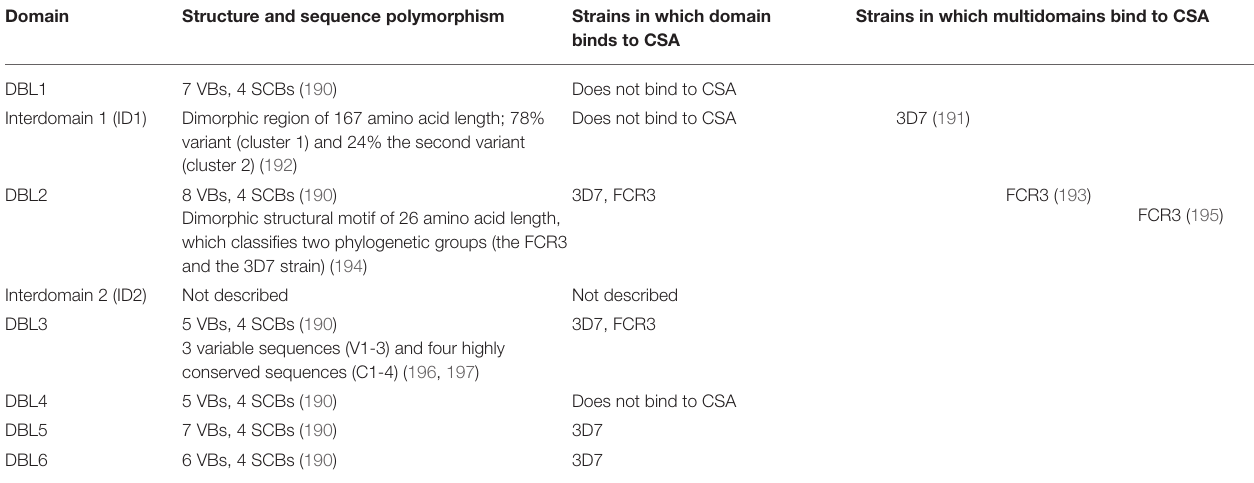
TABLE 2 | Structure and sequence polymorphism of VAR2CSA domains relevant for CSA interaction and sequestration of P. falciparum in the placenta. Domain Strains in which domain binds to